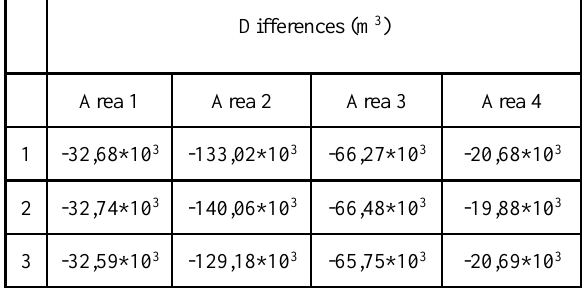
Table 2. Volume differences for the four focus areas calculated by subtracting the 2016 DPC from each of the three DPCs generated from the 2014 dataset.